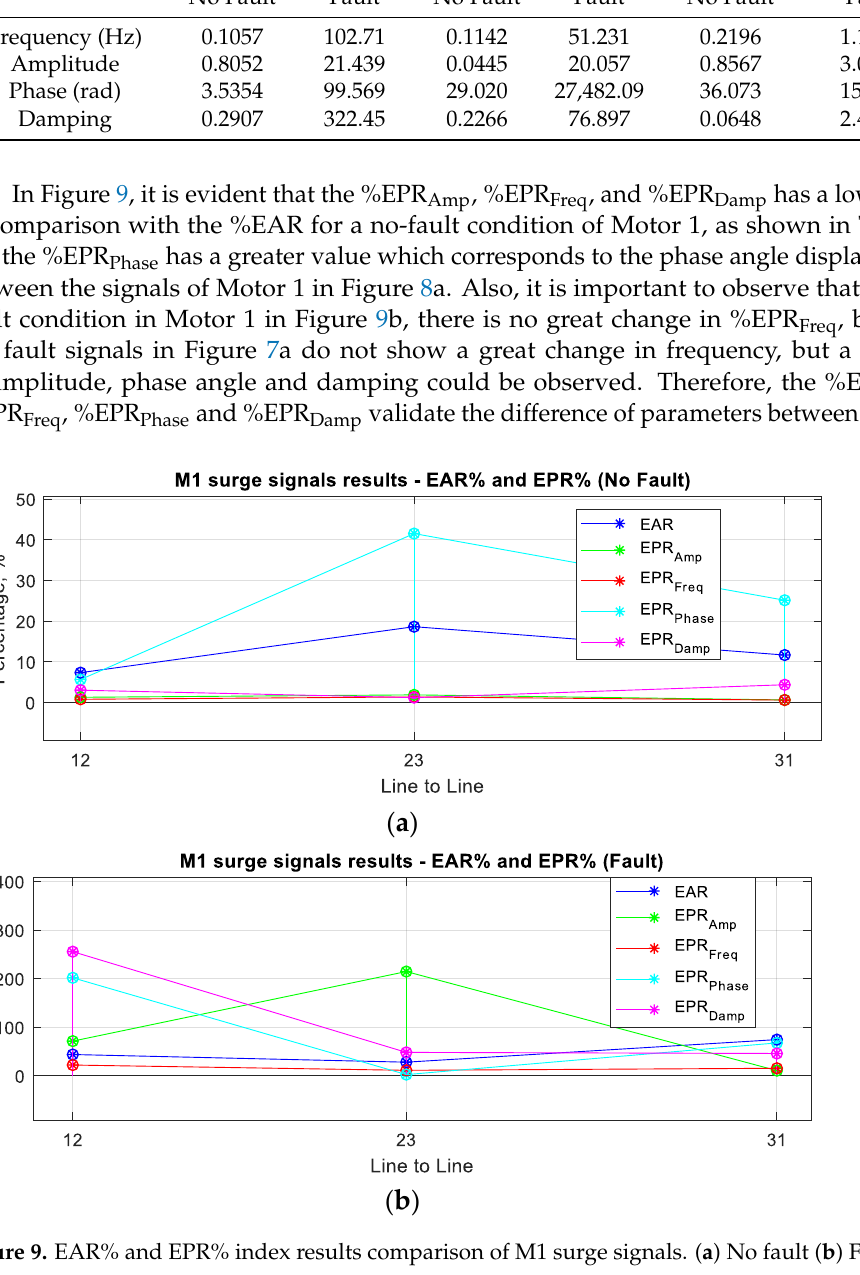
Figure 8. Real surge waveforms curve fitting estimation ( a ) No fault ( b ) Fault .